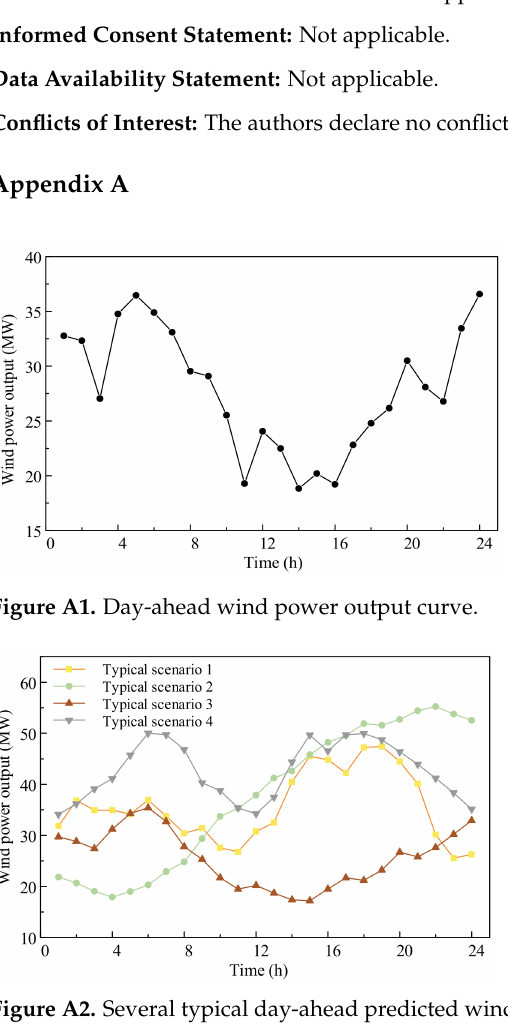
Figure A2. Several typical day-ahead predicted wind power